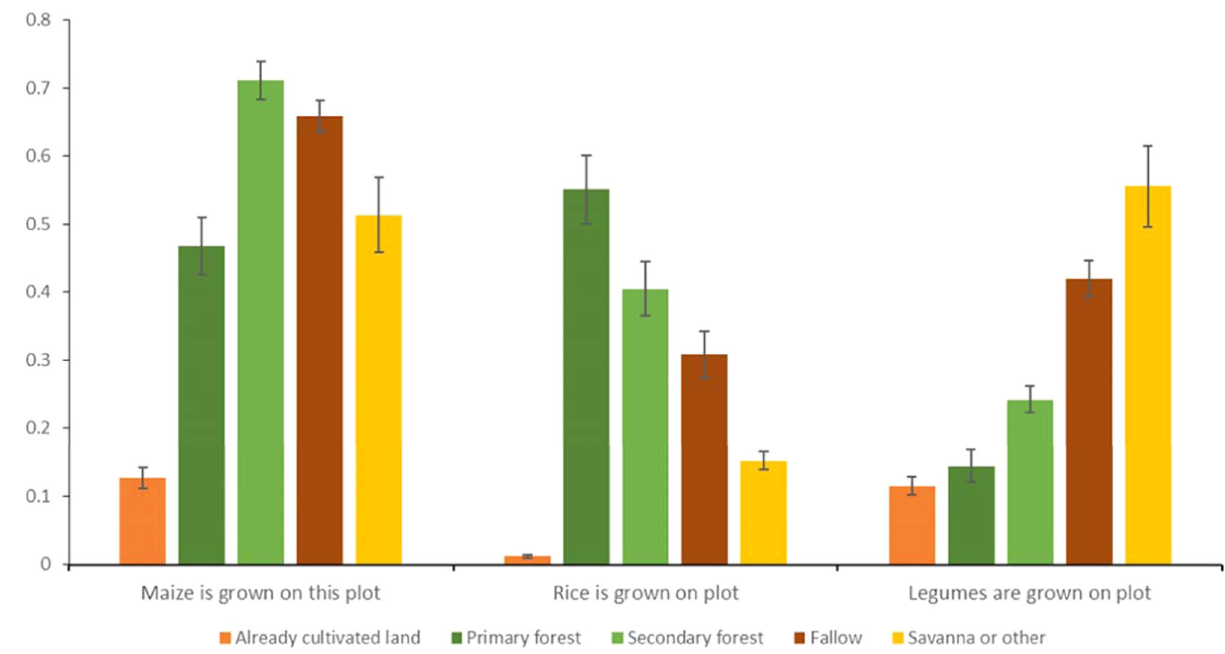
Fig.1|Probabilityofcropsbeinggrownoneachtypeofplot. Note:Resultsfrom Ordinary Least Square regressions on a sample of n =6451 independent plots (several crops can be planted on the same plot in a given year, such that columns do not add up to unity). The dependent variable measures whether the crop was grown on the plot; independent variables indicate the type of plot. Each bar